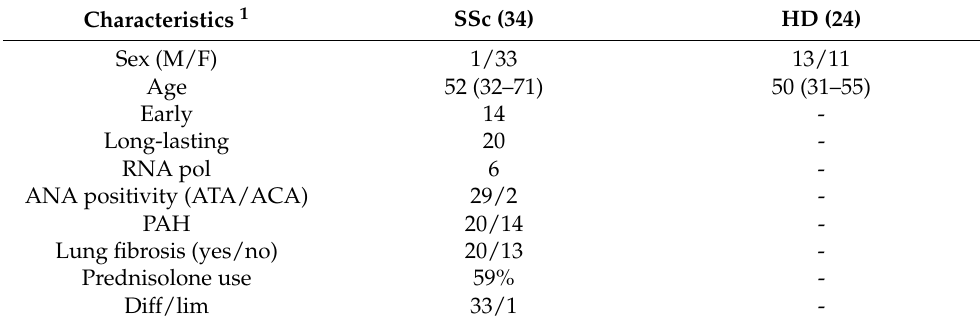
Table 1. Clinical characteristics of patients with